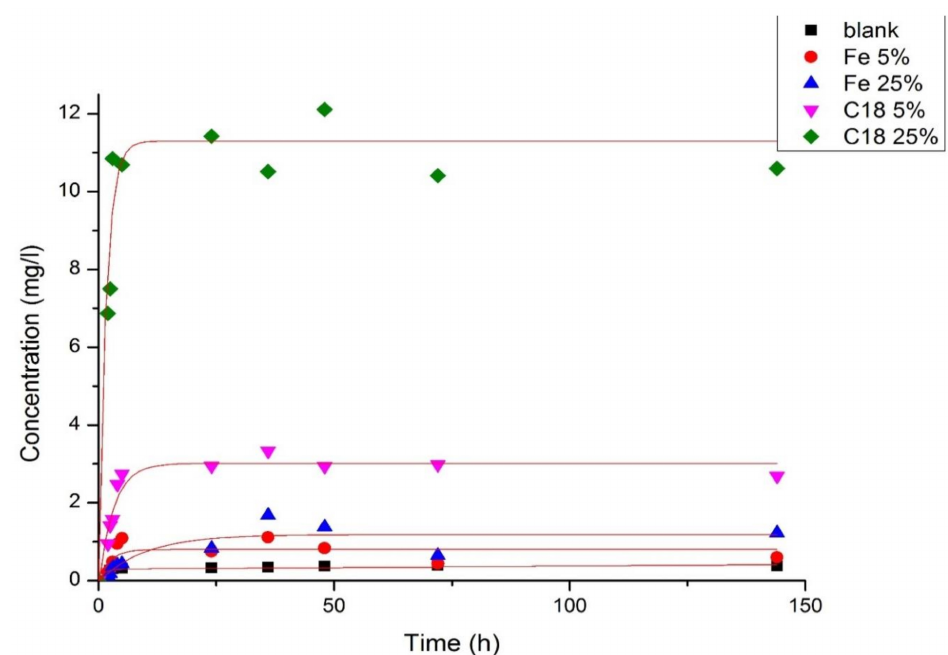
Figure 3. The yield of cholesterol-like substances from the atherosclerotic plaque substance into 0.9% saline under the influence of Fe@C NPs. The black square is the control group. Red circle—non- modified Fe@C NPs at 5% nanoparticle concentration. Blue triangle—non-modified Fe@C NPs at 25% nanoparticle concentration. Pink triangle—modified Fe@C NPs at 5% nanoparticle concentration. Green rhombus—modified Fe@C NPs at 25% concentration of